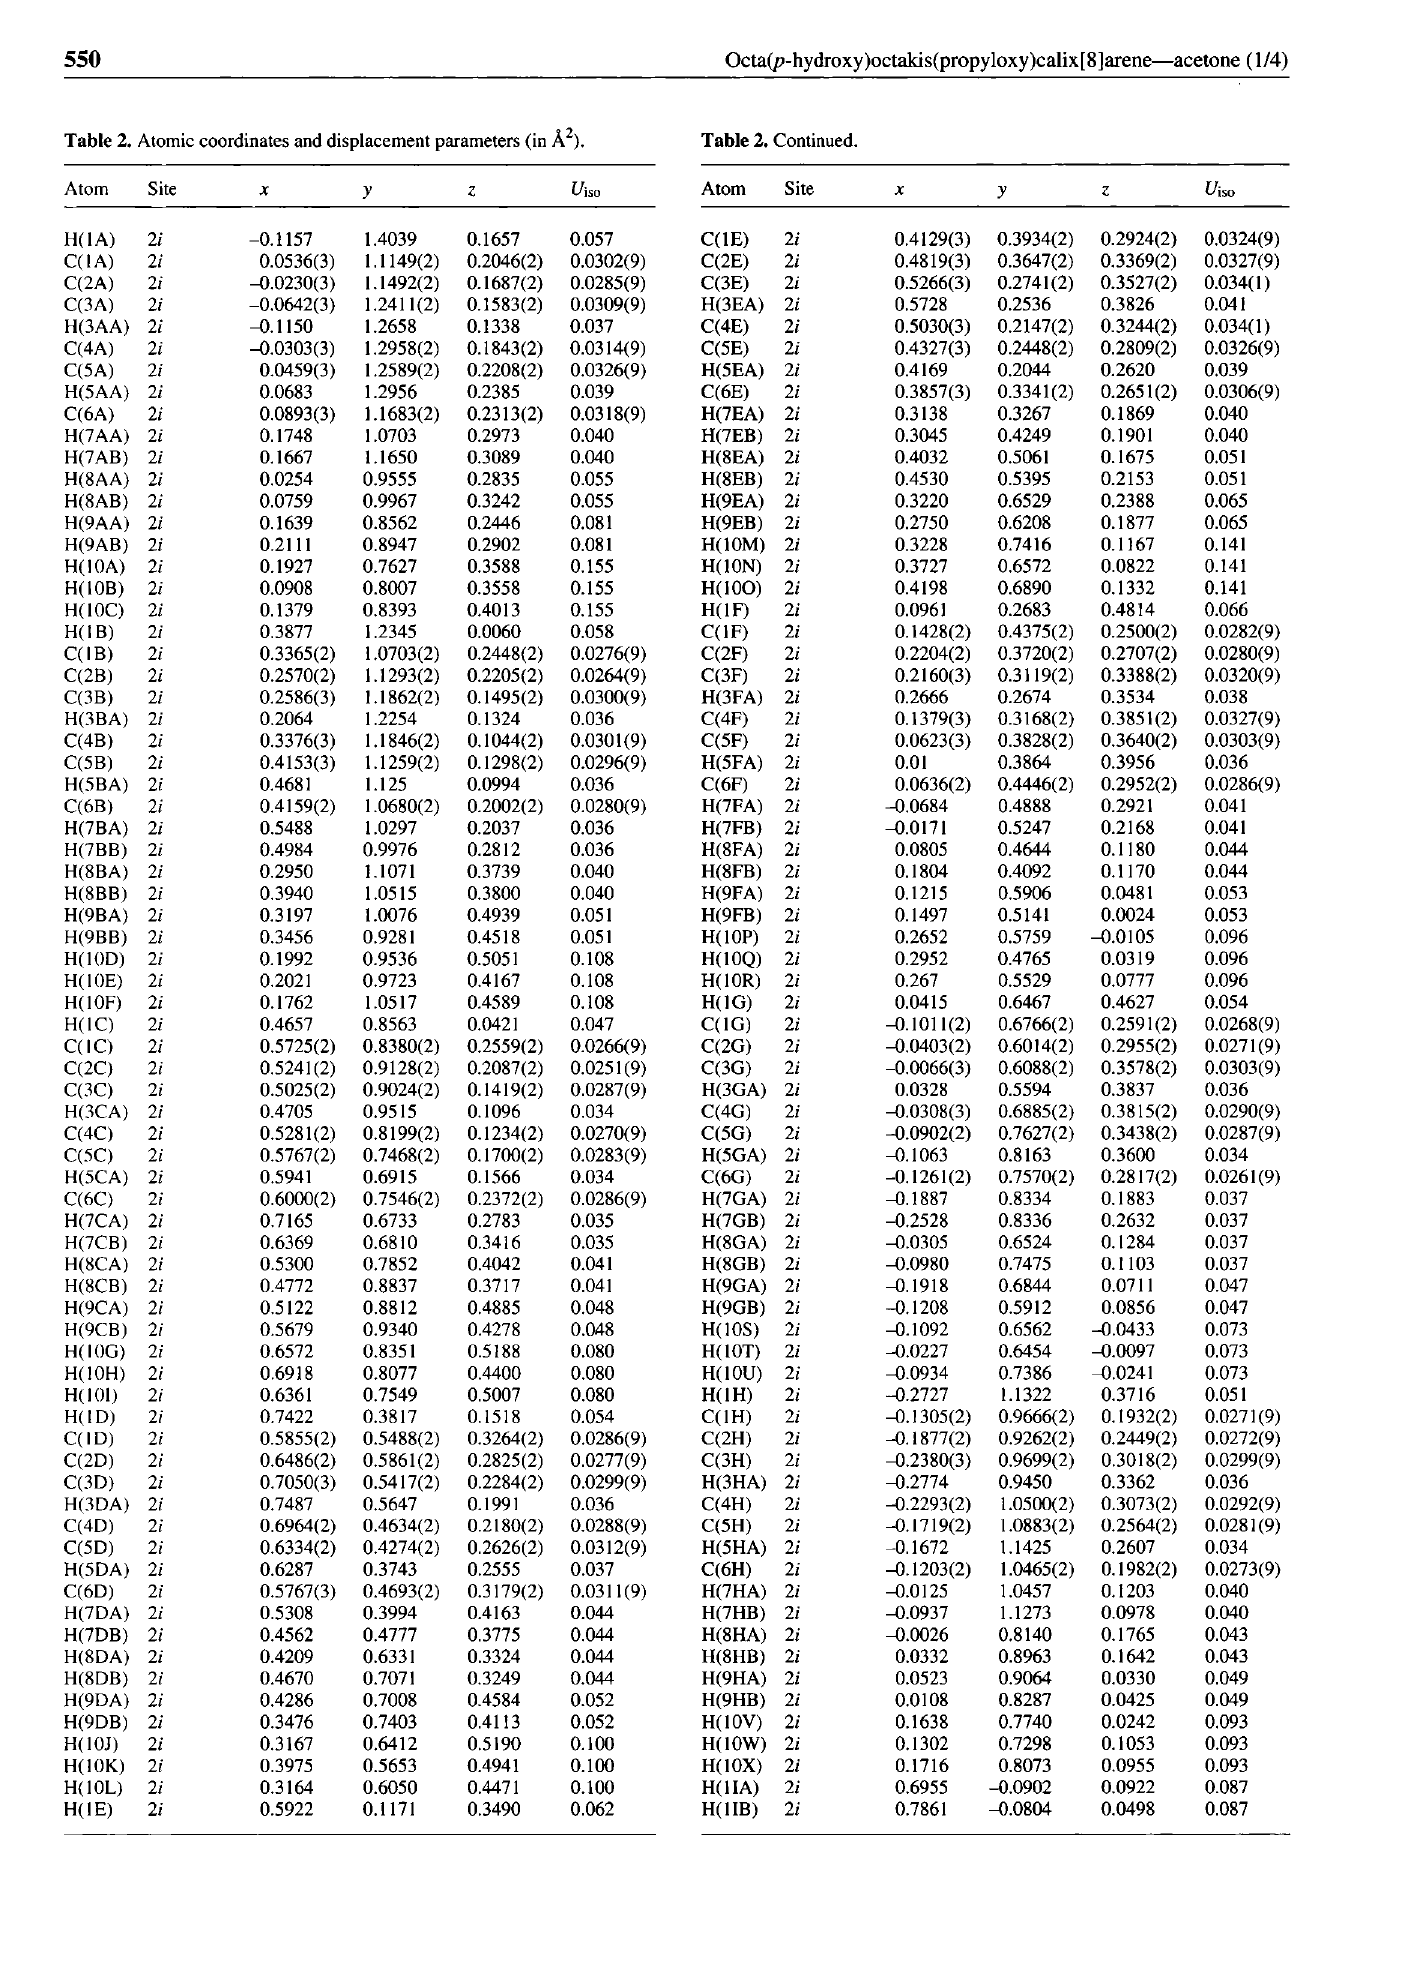
Table 2. Atomic coordinates and displacement parameters (in Ä 2